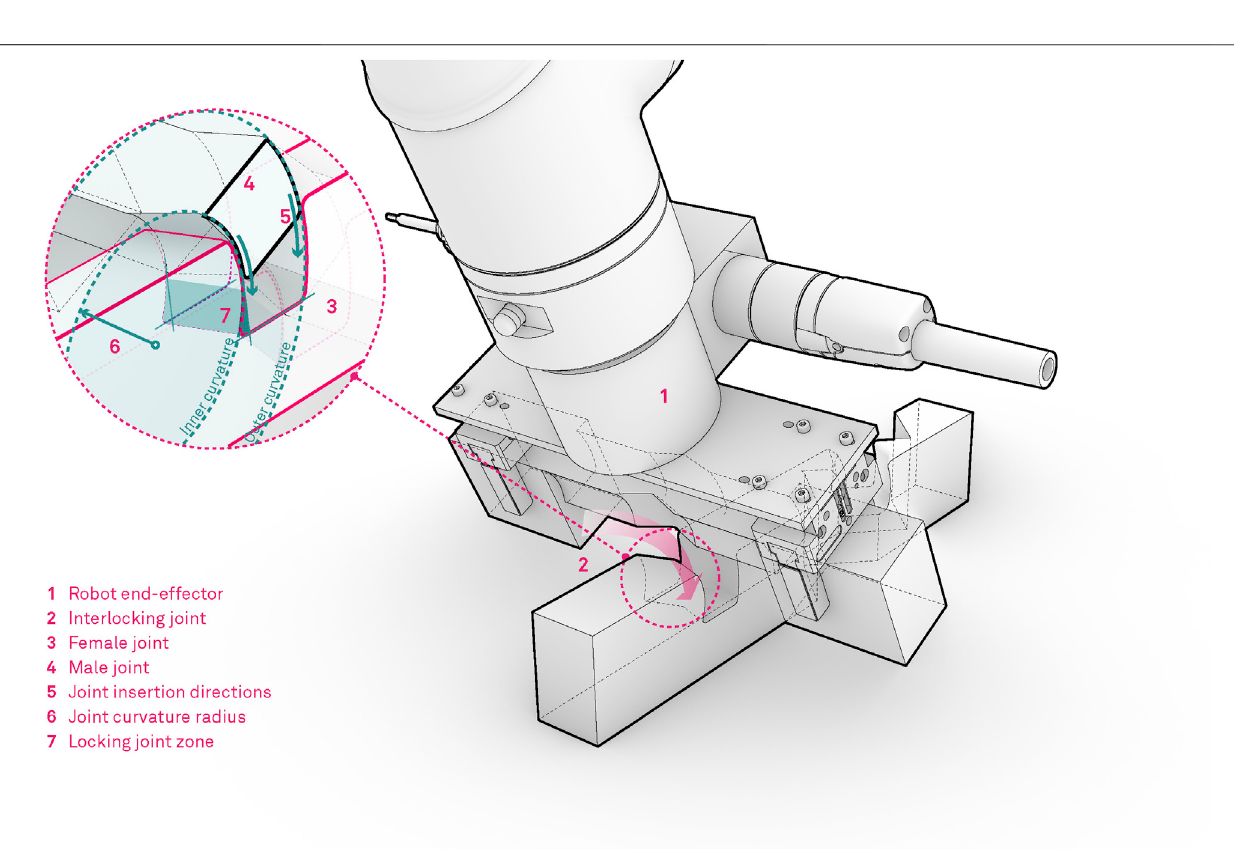
FIGURE 2 | Visual description of the truss design for robotic